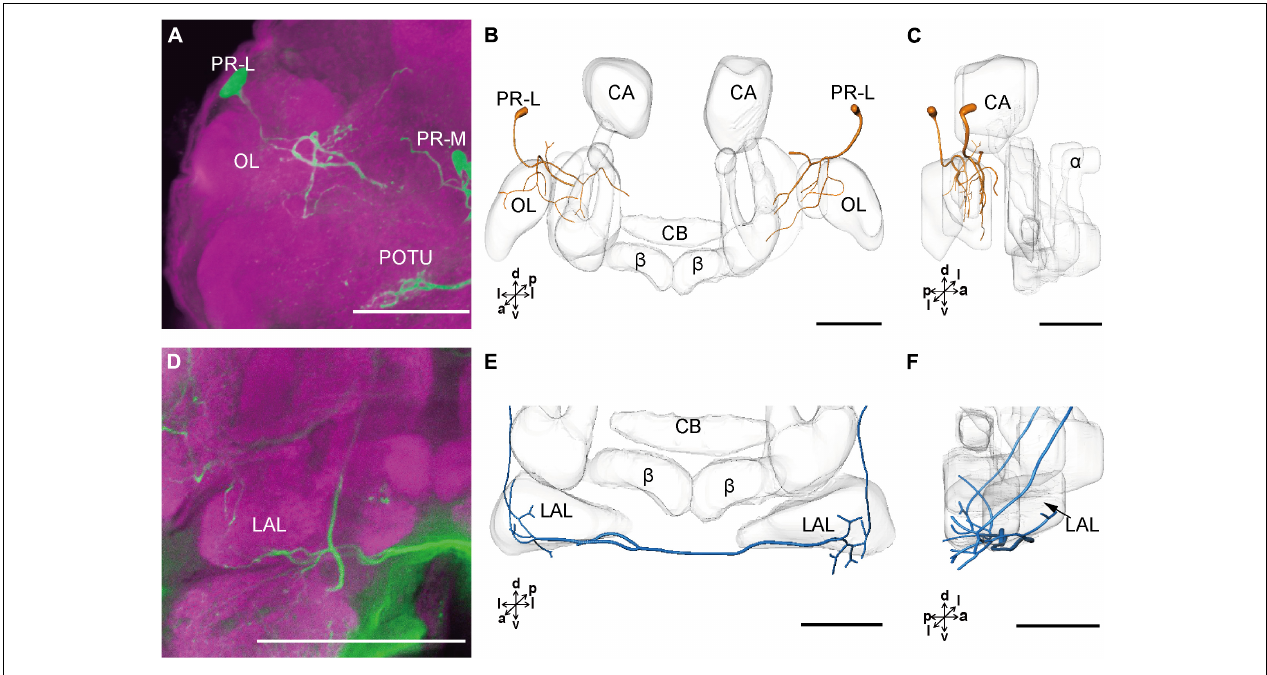
FIGURE 4 | The projection area of PR-L and LAL neurons. (A) The confocal stack images of PR-L neurons. (B,C) The anterior and lateral view of the three-dimensional reconstructions of the PR-L neurons. (D) The confocal stack images of LAL neuron. (E,F) The three-dimensional reconstructions of the LAL neurons in the anterior and lateral views. α , alpha lobe; β , belta lobe; CA, calyx; CB, central body; LAL, lateral accessory lobe; OL, optic lobe; POTU, posterior optic tubercle; PR-M and PR-L are cell clusters. Directions: a, anterior; d, dorsal; l, lateral; p, posterior; v, ventral. Scale bars, 100 µ